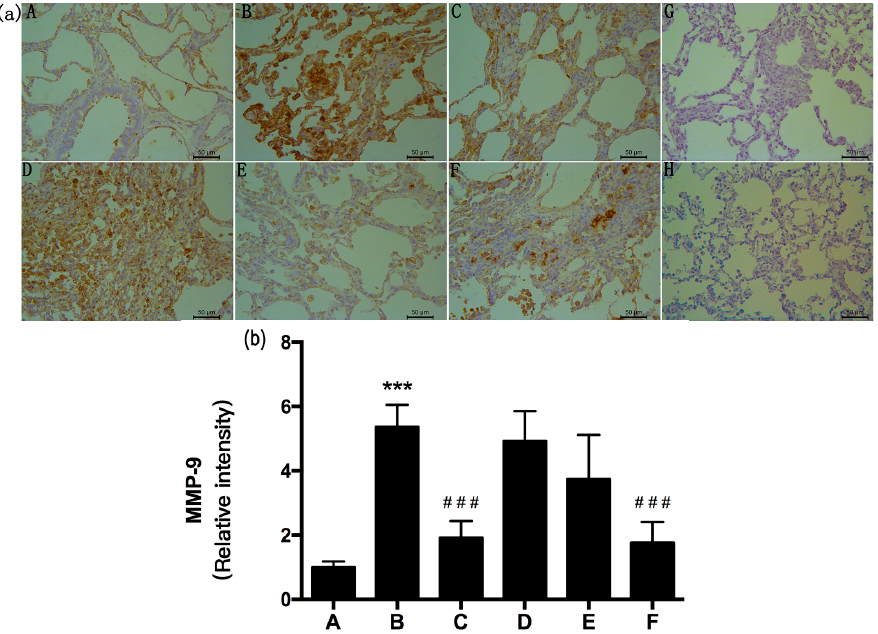
Figure 6. Effects of RRL on the levels of matrix metalloproteinase-9 (MMP-9) in the lung tissues after bleomycin (BLM)-induced in rats. ( a ) representative immunohistochemistry image (Bar = 50 μ m). ( A ) normal group; ( B ) model group; ( C ) PAG group; ( D – F ) are RRL groups treated with 125, 250 and 500 mg/kg, respectively; ( G ) negative control of omitted first antibody; ( H ) negative control of omitted second antibody; ( b ) the quantitative analysis of MMP-9 protein in lung tissues. Data represent the mean ˘ standard deviation (SD) ( n = 3) (*** p < 0.001 vs. normal group, ### p < 0.001 vs. model